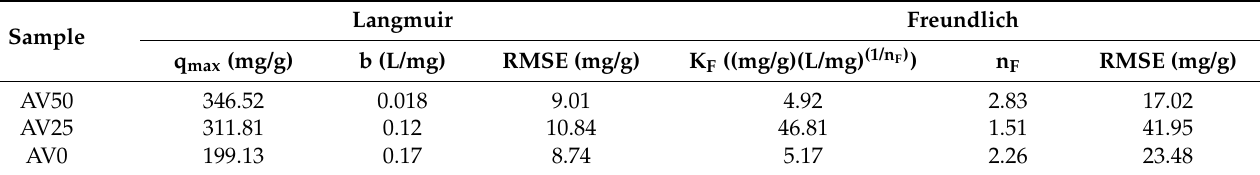
Table 2. Langmuir isotherm parameters for agro-waste adsorbents.